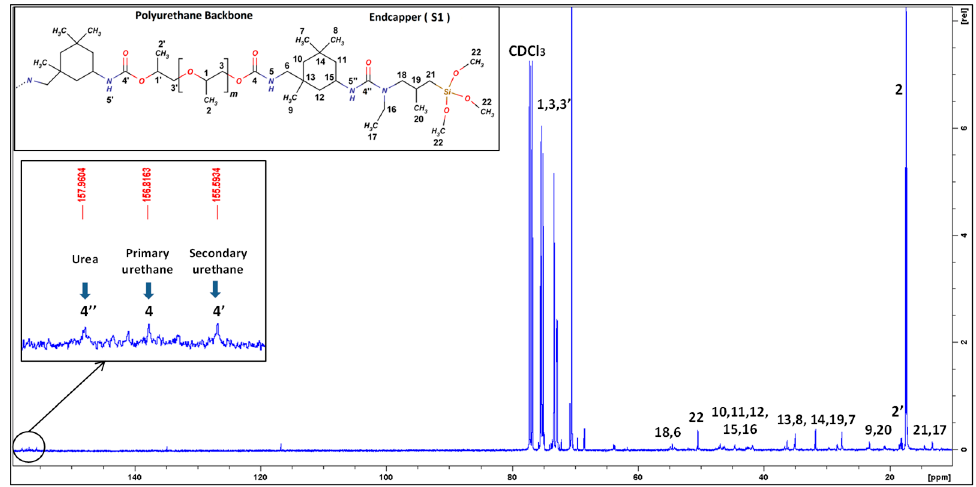
Figure 2. 1 H-NMR spectrum of SPUR 6.